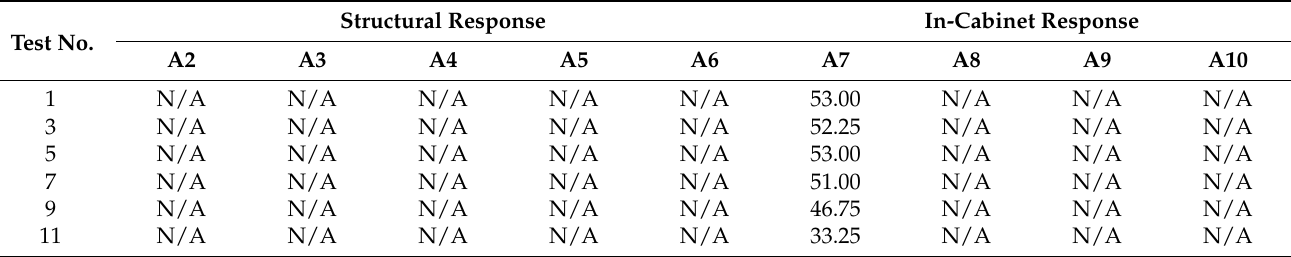
Table 5. Summary of vertical-direction resonant-frequency